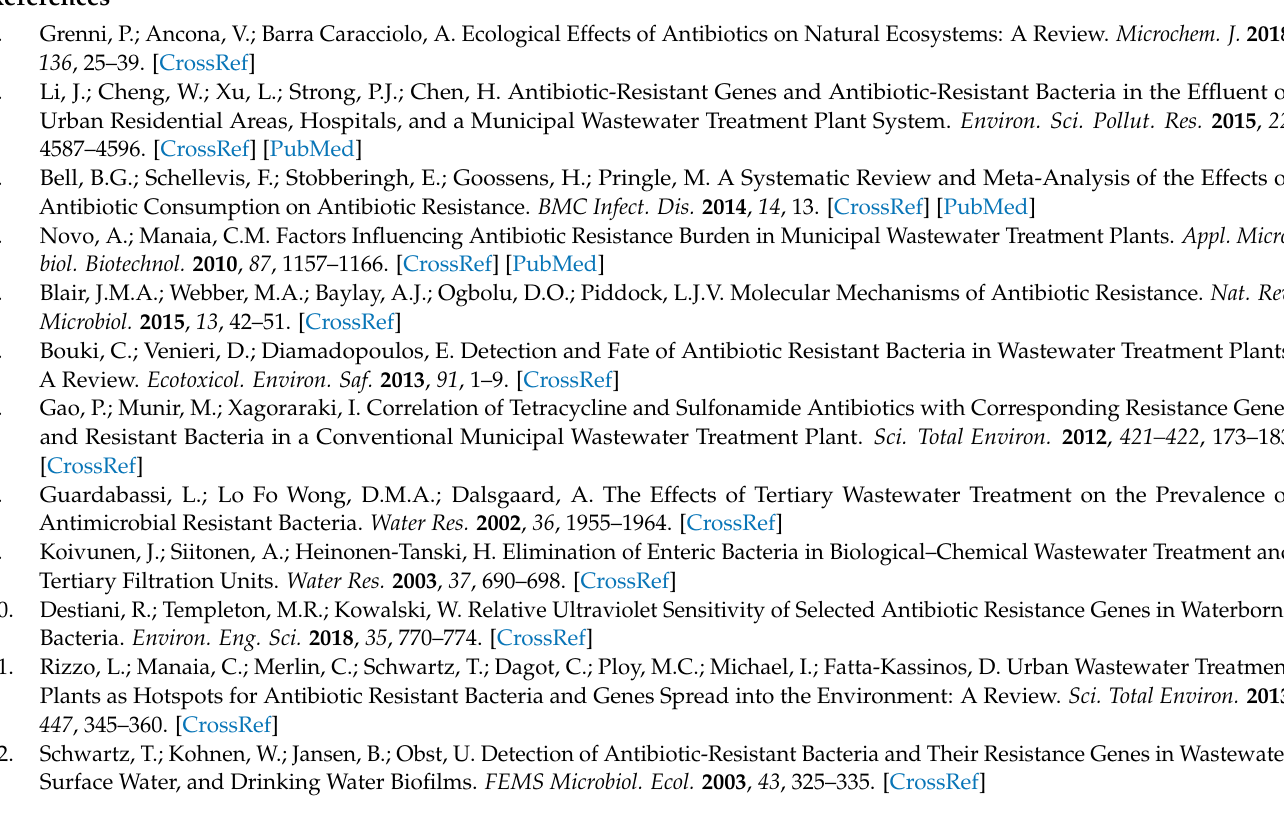
Figure S1: Beta diversities at genus level between Mallard and Sugar Creek; Table S7: Average relative abundance and differential abundance results for families based on antibiotic amendment; Figure S2: Average OTU level Shannon diversity of ARB communities for all locations; Table S8: Average colony counts for incubation temperature and media; Figure S3: Beta diversity and taxonomic differences between stream communities; Figure S4: Relative abundance for stream and sewage communities; Figure S5: Beta diversity and taxonomic differences between sewage communities; Table S9: Average Shannon diversity for incubation temperatures and media; Table S10: Significant differences in taxa between incubation temperatures and media; Table S11: Relative abundance and significant differences in cultured and environmental families; Figure S6: Relative abundance of families based on incubation condition and antibiotic